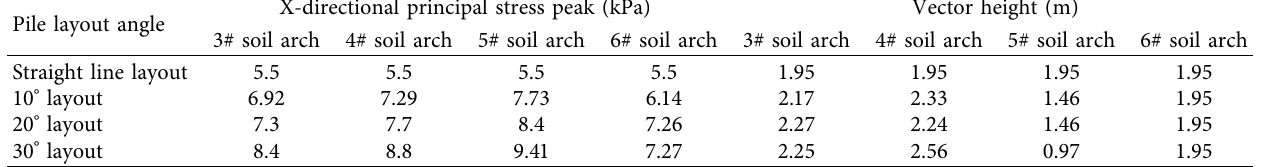
Table 3: Peak and vector height statistics for the X-directional principal stresses of soil arches.